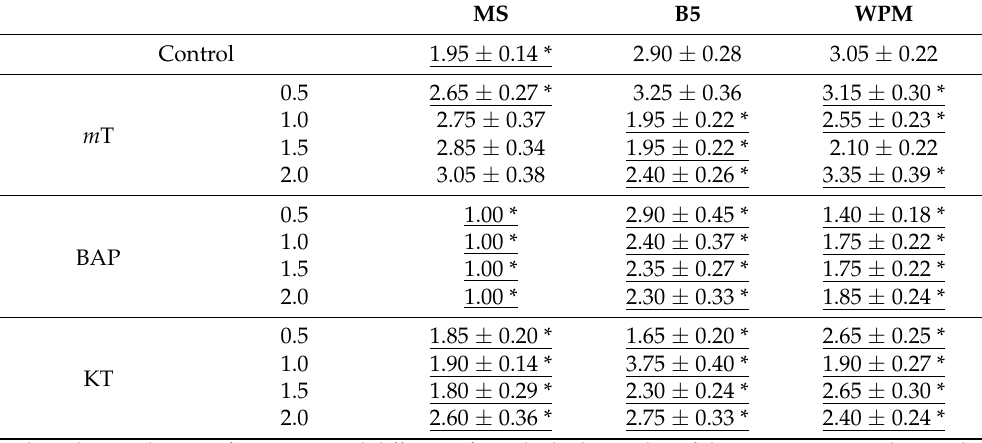
Table 4. Average values of M. fragrans multiplication coefficient on different nutrient